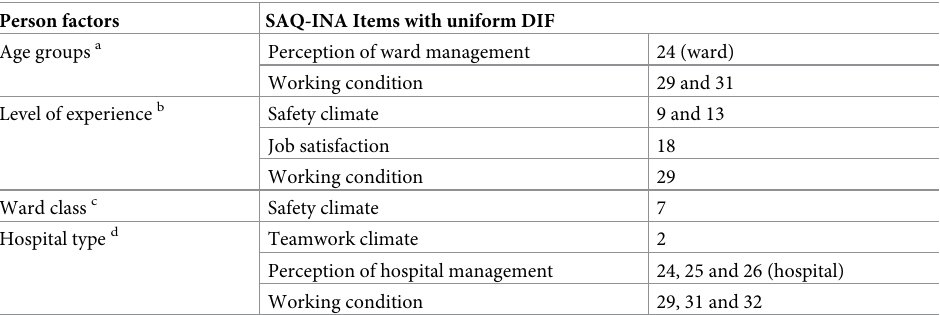
Table 4. Item bias across person